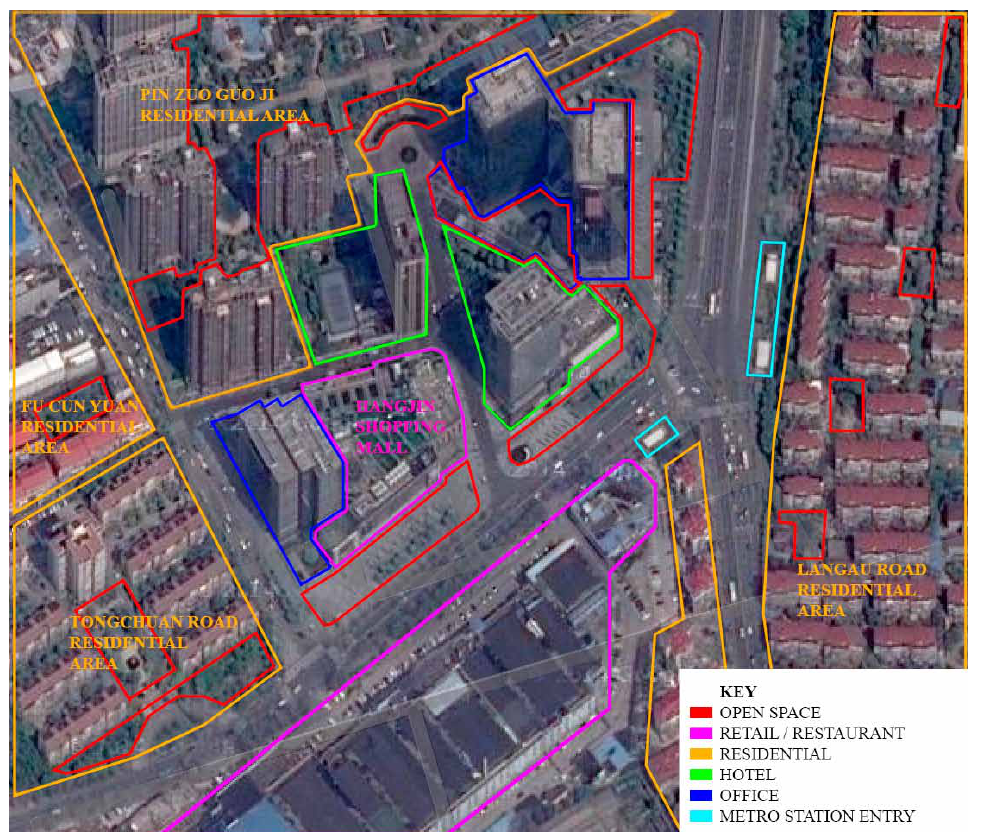
fig. 2. aerial view of Putuo District adjacent to langao road Subway Station, Shanghai (aerial view...